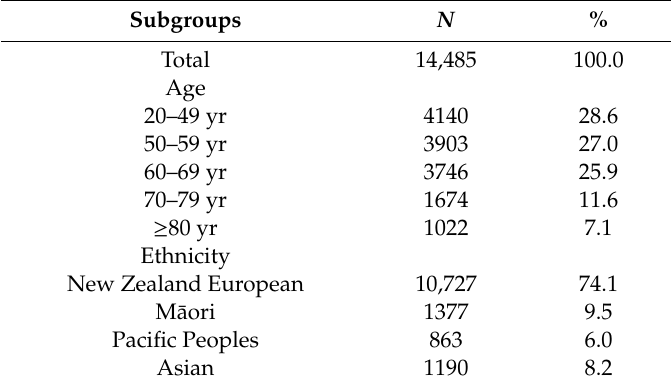
Table 1. Patient characteristics shown in